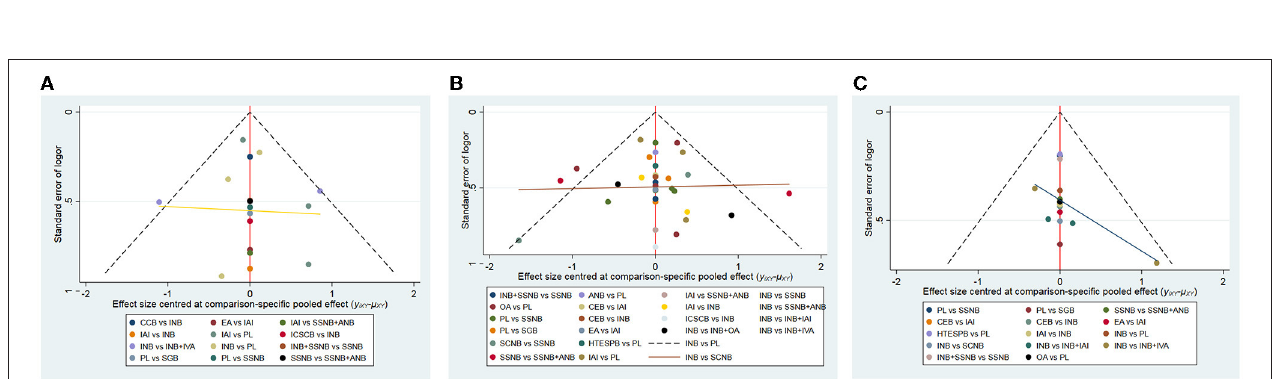
FIGURE 8 | The comparison-adjusted funnel plot of network meta-analyses. [ (A) postoperative 12h, (B) postoperative 24h, (C) postoperative 48h]. INB, interscalene nerve block; SCNB, supraclavicular nerve block; SSNB, suprascapular nerve block; HTESPB, high thoracic erector spinae plane block; CEB, cervical epidural block; SGB, stellate ganglion block; ICSCB, infraclavicular-suprascapular blocks; CCB, costoclavicular blocks; ANB, axillary nerve block; IAI, intra-articular injection; OA, oral administration; EA, external application; IVA, intravenous administration; PL, placebo.